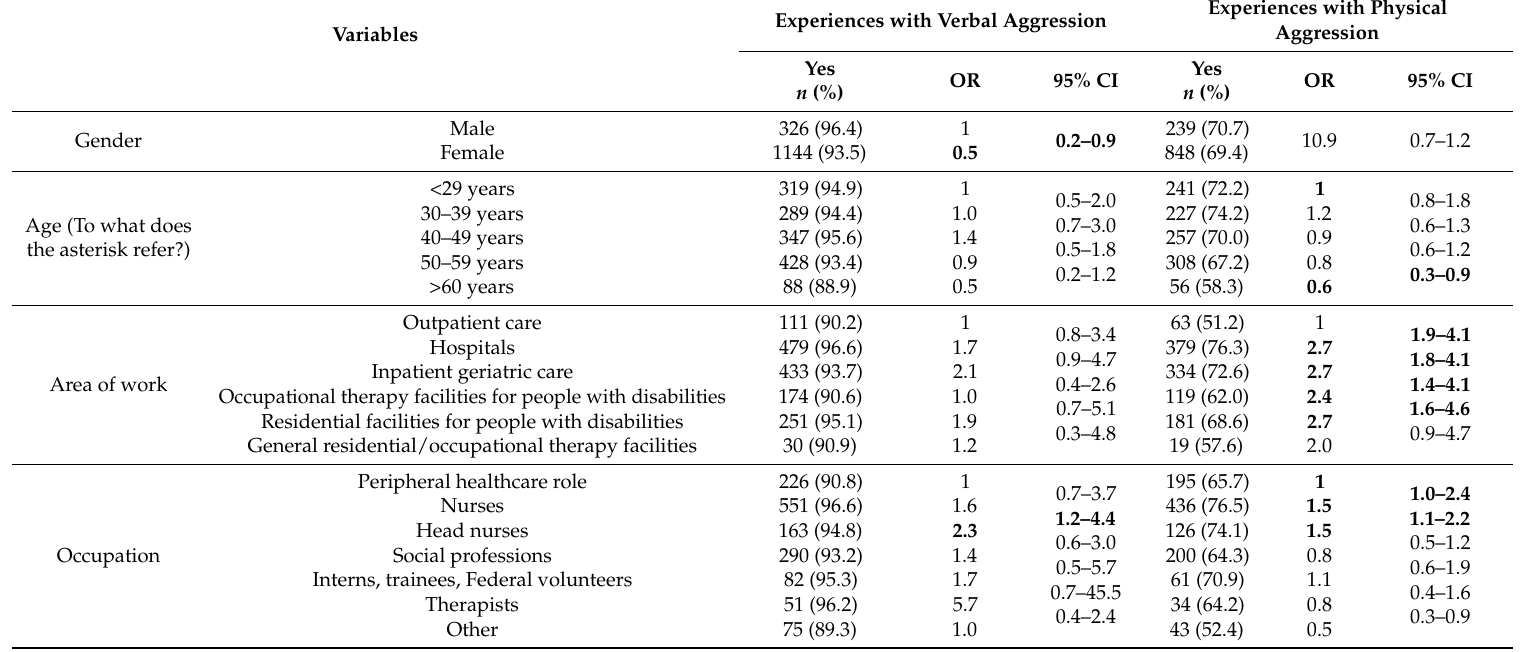
Table 5. Frequency and odds ratios for verbal and physical violence ( n =